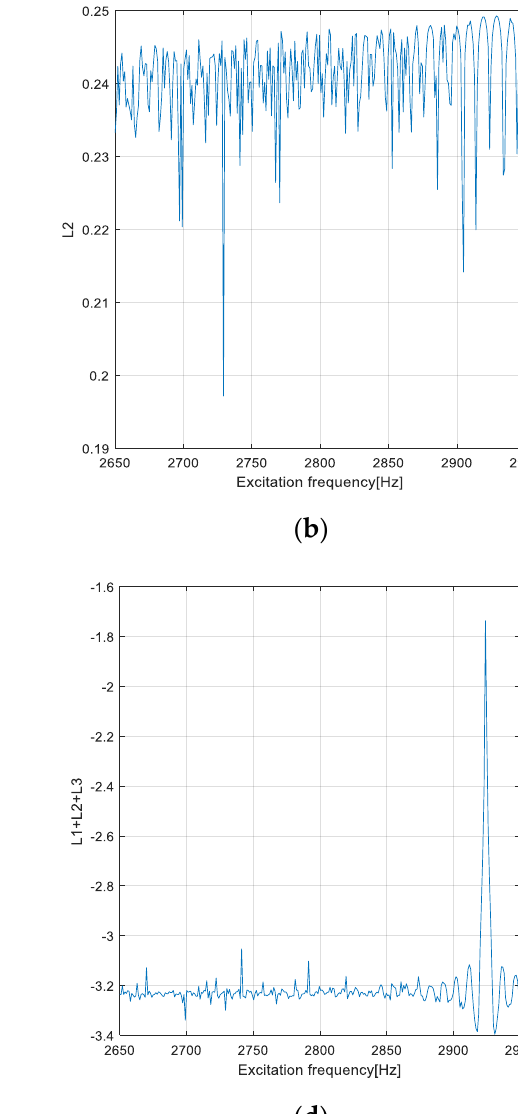
Figure 21. Lyapunov exponents of NFTV for DOE3,